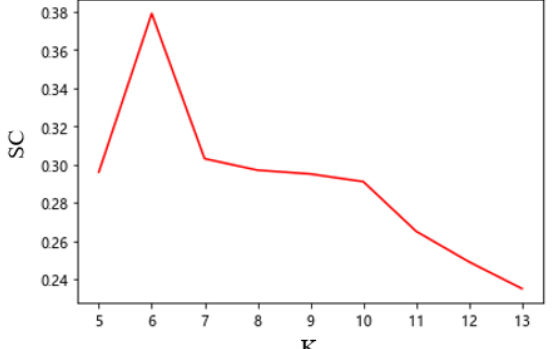
Figure 5. Silhouette coefficients for different K values.